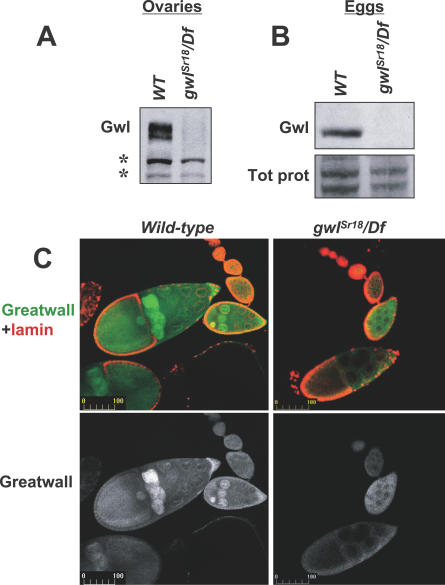
Gwl Is Supplied by the Mother to the Developing Egg(A) Anti-Gwl western blot from ovaries of gwlSr18/Df or WT (Oregon R) females.(B) Anti-Gwl western blot from extracts of eggs laid by gwlSr18/Df or WT (Oregon R) virgin females. Total proteins were stained by amido black, shown as a loading control. *, cross-reactive band acting as a loading control.(C) Localization of Gwl in ovaries. In addition to Gwl (green), lamin (red) was also stained to show the outlines of the cells and of their nuclei. In WT ovaries, Gwl is clearly visible in the nucleus and the cytoplasm of the oocyte and in the nuclei and cytoplasm of the four nurse cells connected to it. In gwlSr18/Df ovaries, only follicle-cell staining of Gwl-short and/or background staining is detected. Scale bars are in μm.